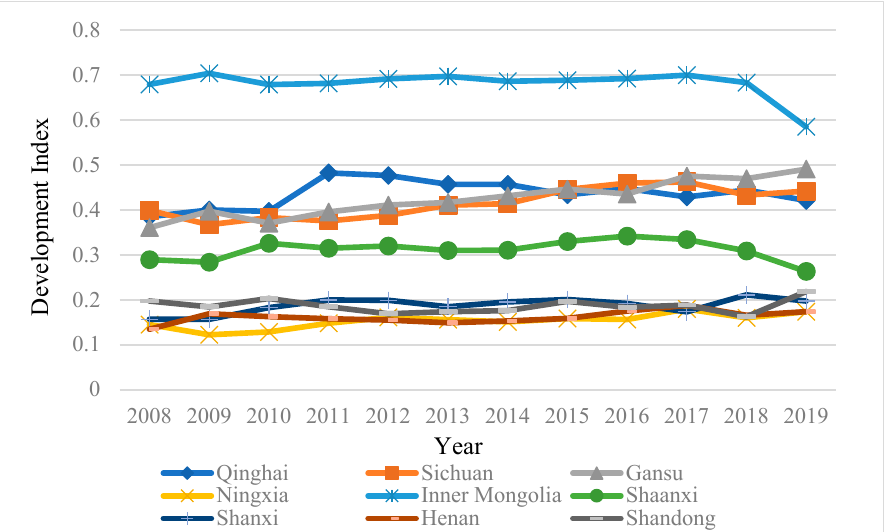
Figure 3. Ecological Environment Development Status of Nine Provinces in the Yellow River Basin from 2008 to 2019.